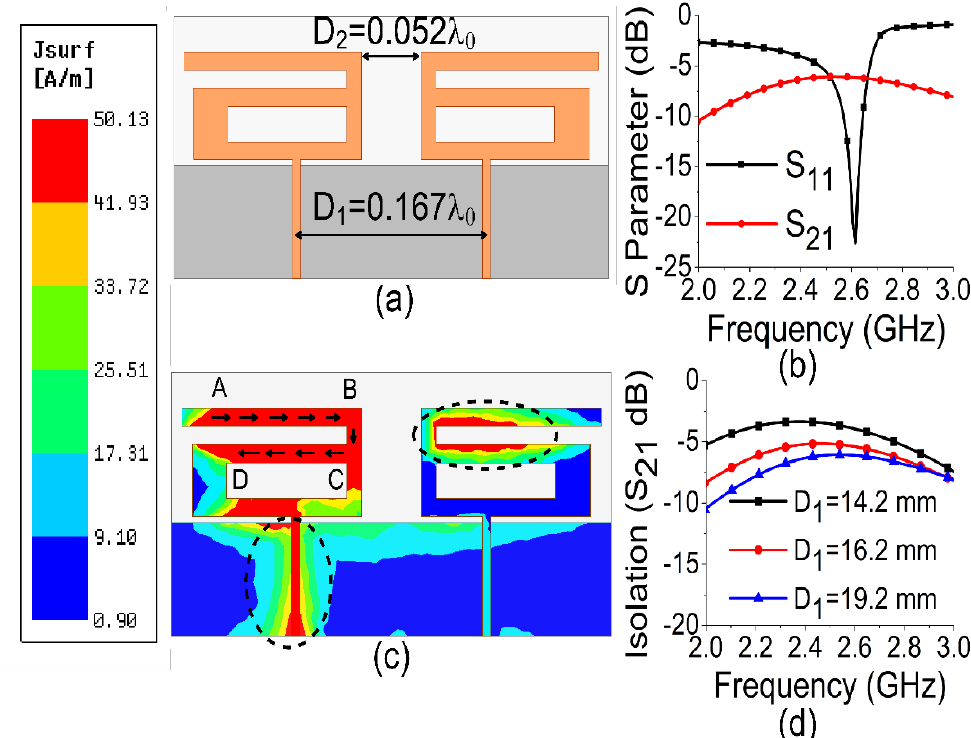
Figure 2. Basic MIMO antenna: ( a ) configuration; ( b ) S parameters; ( c ) current; ( d ) spacing effect between the antennas.